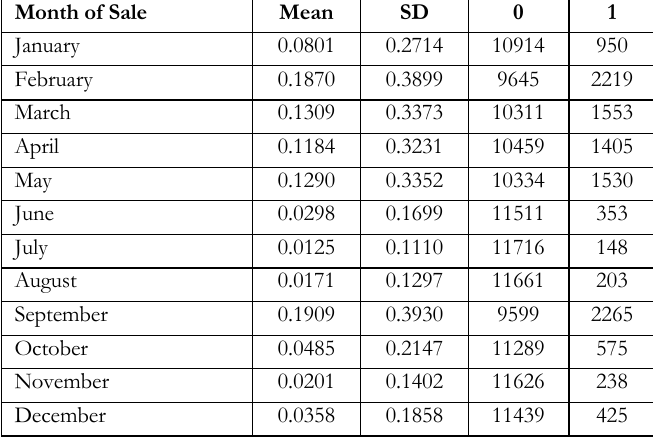
Table 4: Descriptive Statistics of the Month of Sale